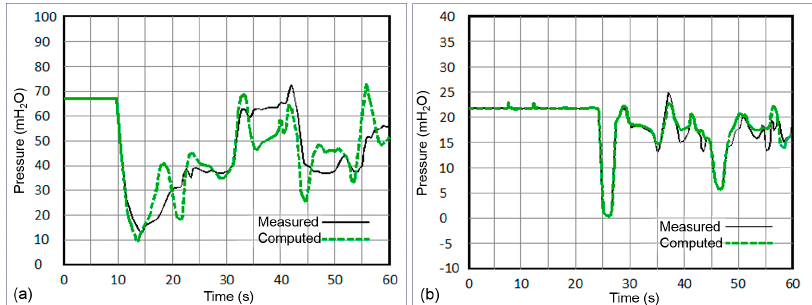
Figure 13. Measured and computed pressure traces ( a ) at discharge header of Pumping Plant 1 and ( b ) at the air valve located at station 13 + 600.